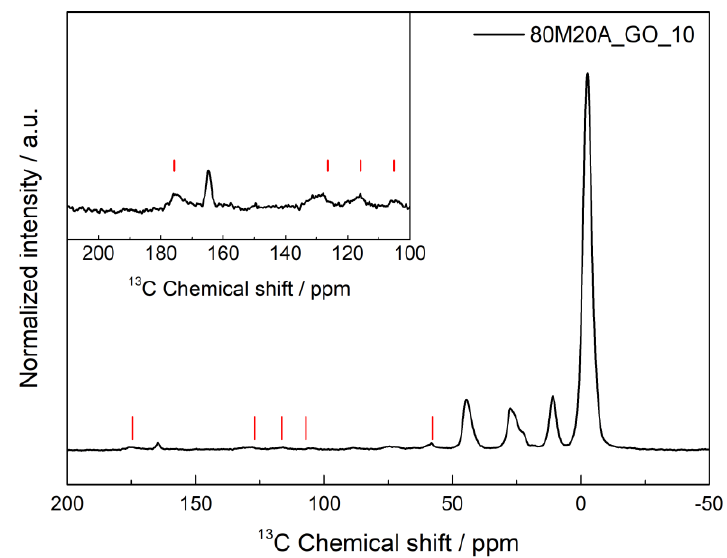
Figure 7. 1 H– 13 C heteronuclear solid-state NMR spectra of 80M20A_GO_10 after the adsorption process of amoxicillin. The red lines indicate the detected AMX peaks. The inset shows a vertical expansion of the spectral range where the AMX peaks are present.